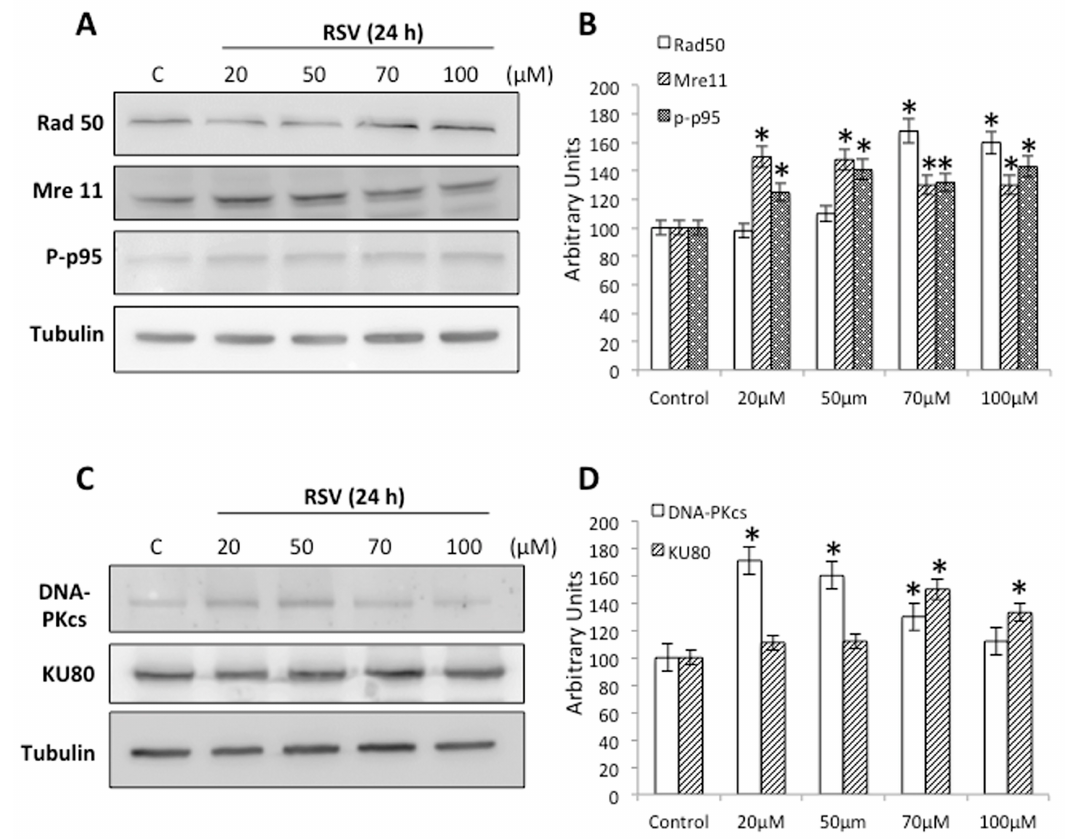
Figure 4. Effect of Resveratrol on the activation of double-strand break repair pathways. ( A ) Western blot analysis of proteins from cells treated with different concentrations of RSV for 24 h using anti-Rad50, anti-Mre11 and anti-p-p95/NBS1 antibodies. Antibodies against total tubulin were used as loading control. ( B ) Quantification of the proteins shown in panel A is represented as a column plot with error bars. ( C ) Western blot analysis of proteins from cells treated with different concentrations of RSV for 24 h using anti-DNA-PKcs and anti-KU80 antibodies. Antibodies against total tubulin were used as loading control. ( D ) Quantification of the proteins shown in panel C is represented as a column plot with error bars. Results are representative of three independent experiments, * p < 0.05 compared to control cells.